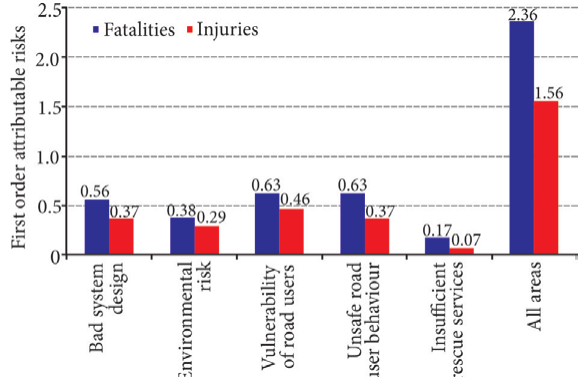
Fig. 2. Importance of risk factors in contributing to traffic accidents and injuries (Elvik et al.